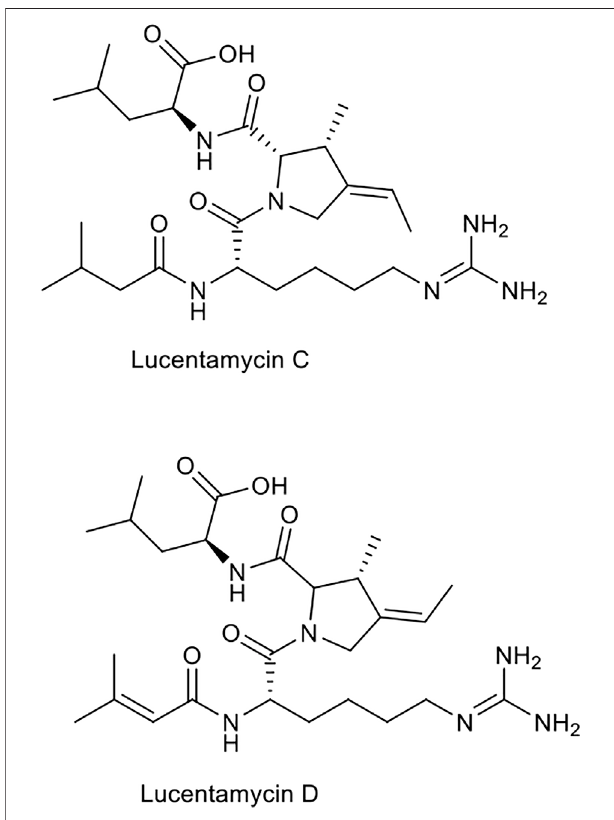
FIGURE 12 | Chemical structure of lucentamycins C and